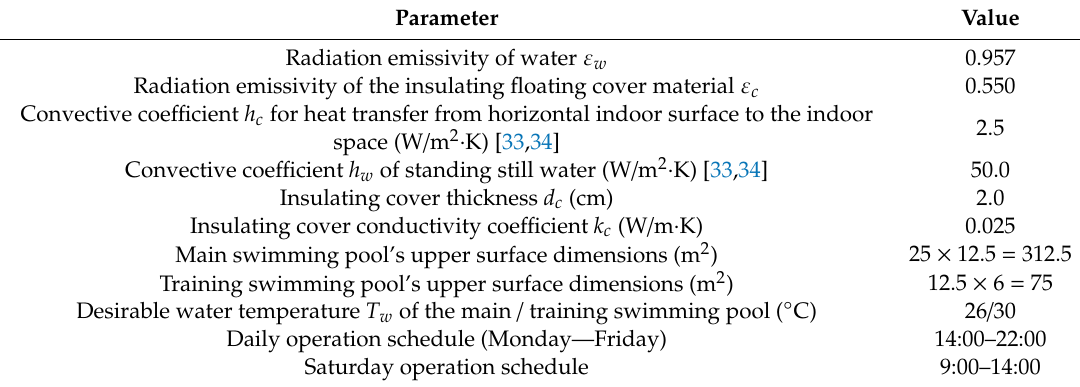
Table 2. Calculation parameters for the swimming pool’s heating loads calculation in the existing and the proposed operation.